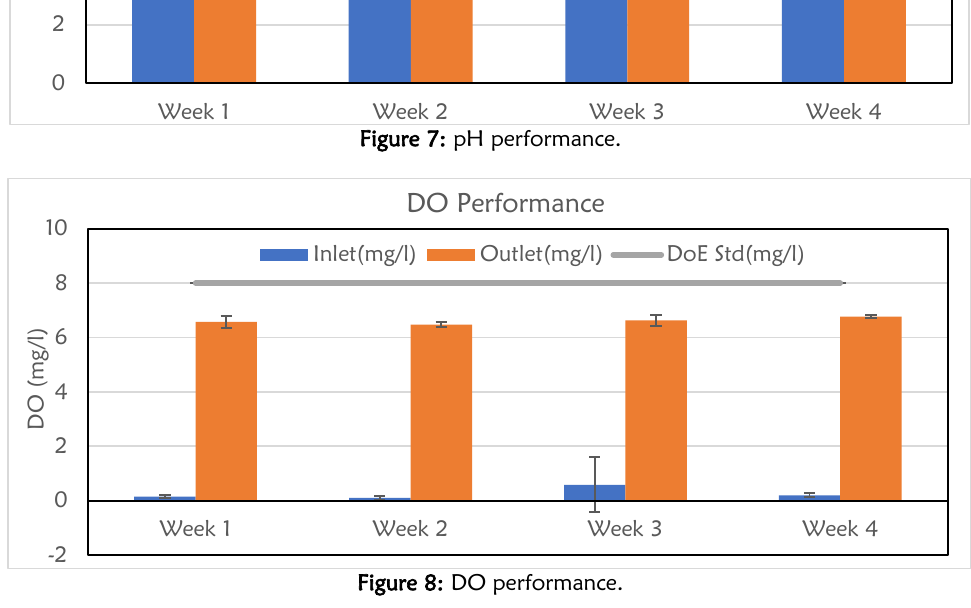
Figure 7: pH performance.